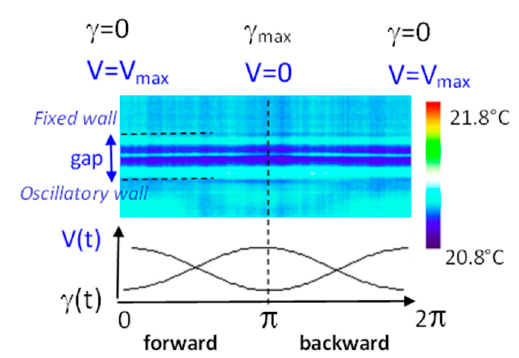
Figure 15. Polymer slab of 0.185-mm-thickness under oscillatory strain: the melt exhibits non-uniform temperatures with the emergence of cold thermal bands (dark blue) coexisting upon applying an oscillatory shear stress of ( γ = 1200%, ω = 2 rad/s). The bottom curves illustrate the strain and the velocity over a period. Complementary information is available in references [58,59].